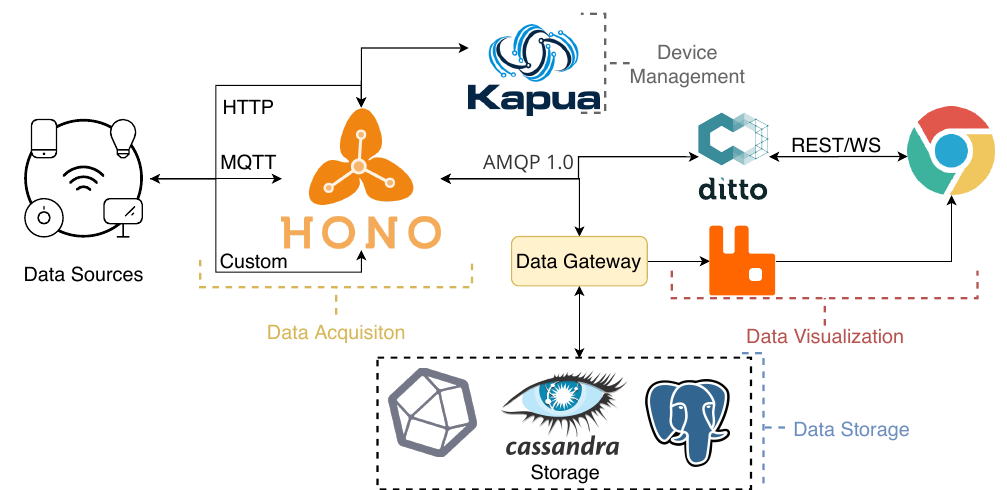
Figure 2. Redesign of the SCoT’s architecture to support dynamic IoT